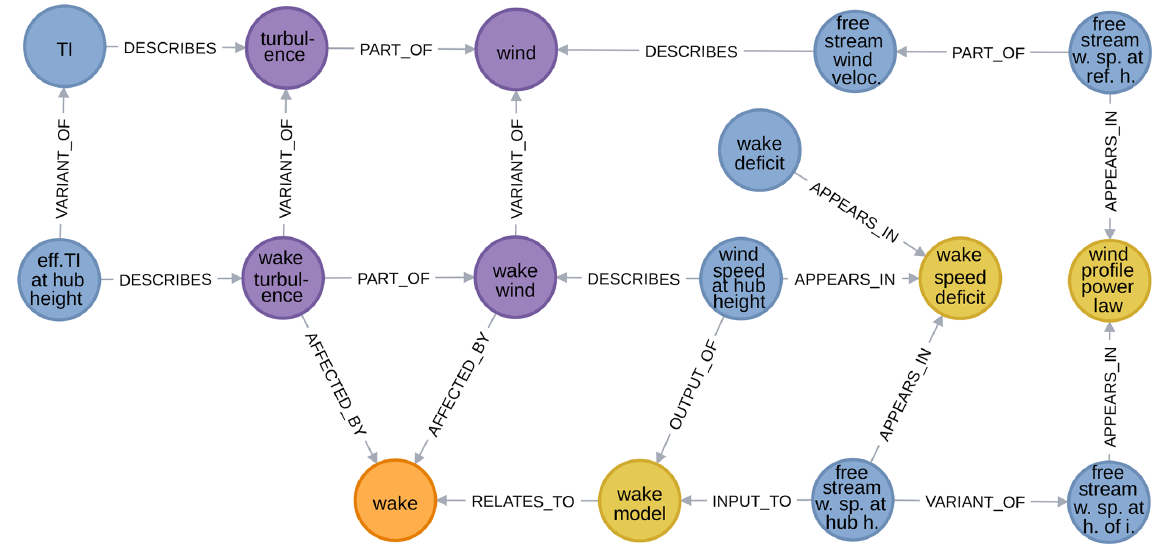
Figure 10. Subgraph defined a phenomenon , its AFFECTED BY and RELATES TO relationships, and its context (excerpt from